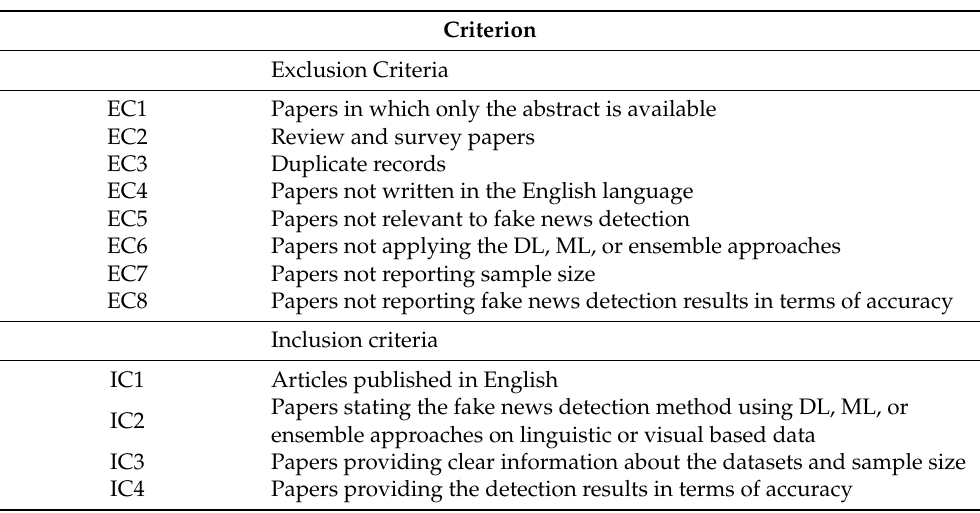
Table 1. Exclusion and inclusion